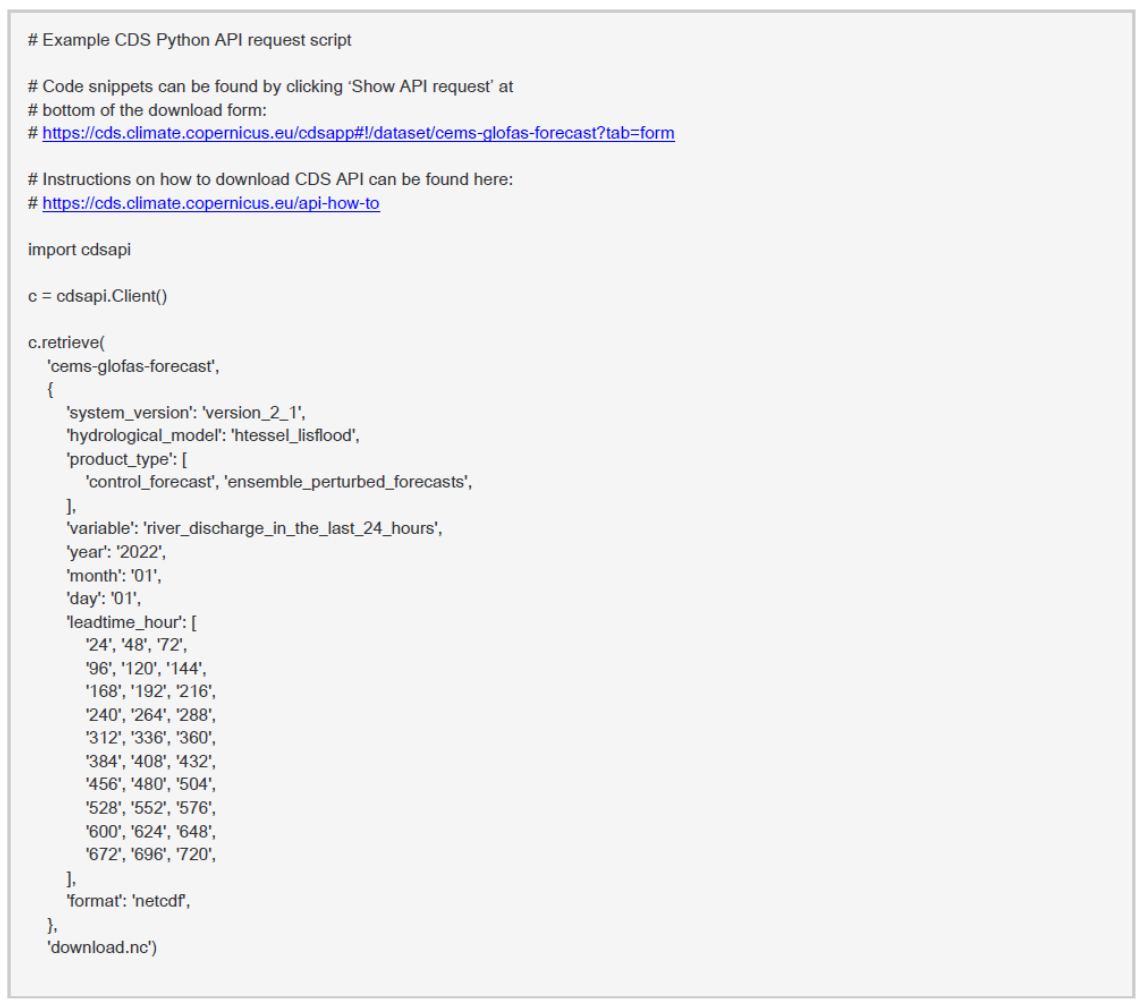
Figure B1. Example Climate Data Store (CDS) Python API retrieval script for the GloFAS v2.1 daily river discharge forecast on 1 Jan- uary 2022 for both the single control (CTL) forecast and 50 ensemble perturbed members out to a lead time of 30d to be downloaded in NetCDF